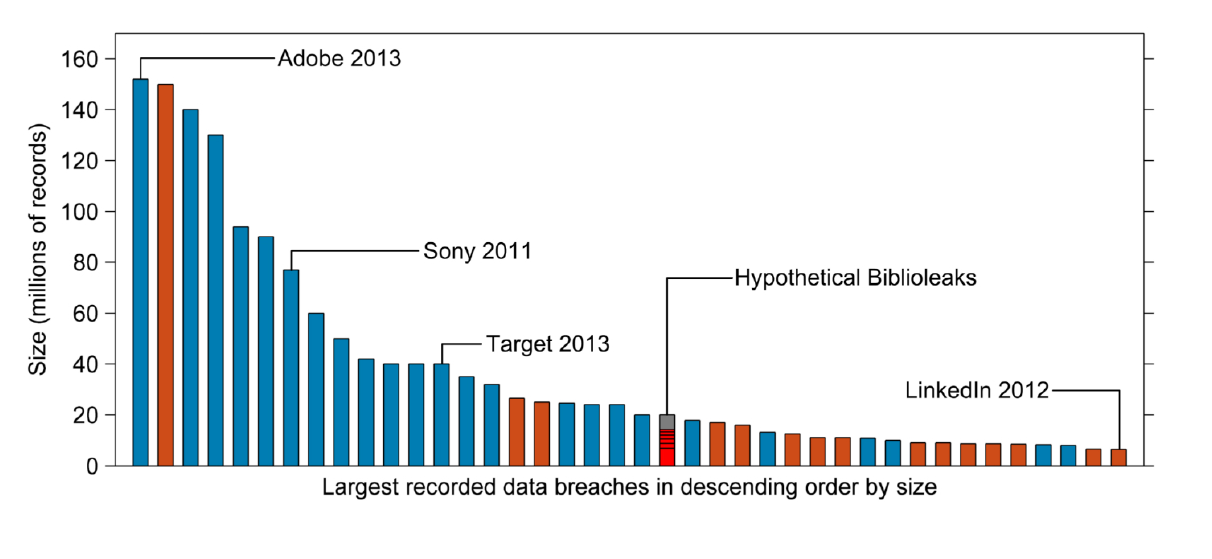
Figure 2. Largest recorded data breaches by number of records (accessed 7 January 2014). Hacks are in blue, all other breach types in orange (eg, stolen/lost disks)–compared to a hypothetical breach equivalent to the numbers of articles indexed by PubMed for which full-text versions require a subscription or payment to access. The proportions associated with the 6 largest publishers (sampled from outgoing PubMed links on 7 January 2014) make up 72% of these inaccessible articles (in